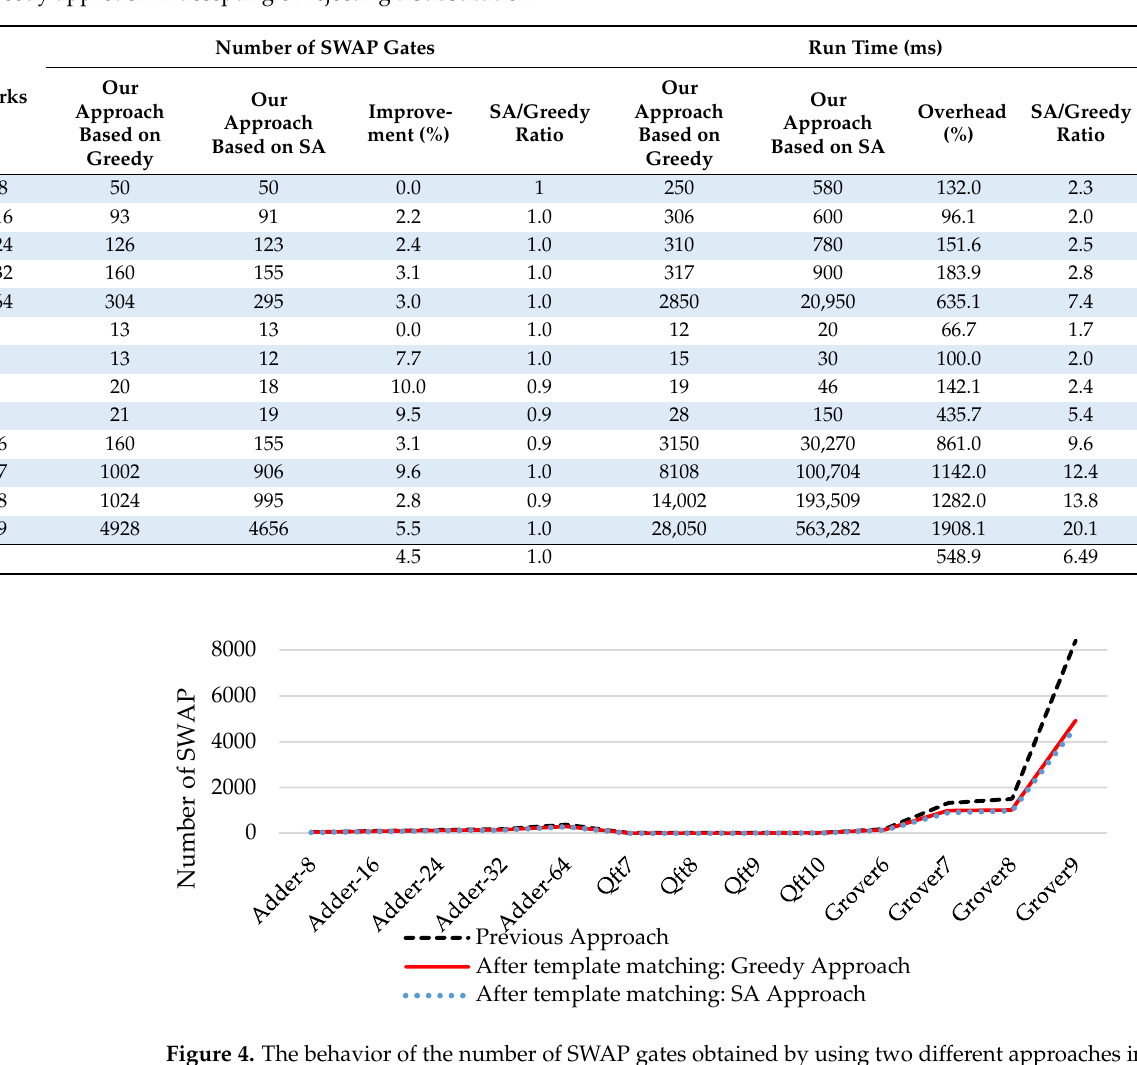
7 Table 2. The number of SWAP gates of the benchmark circuits achieved by using simulated annealing heuristics compared with our greedy approach in accepting or rejecting a substitution.